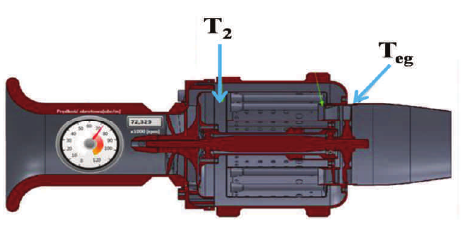
Fig. 1. MiniJetRig testing stand. Source [9]